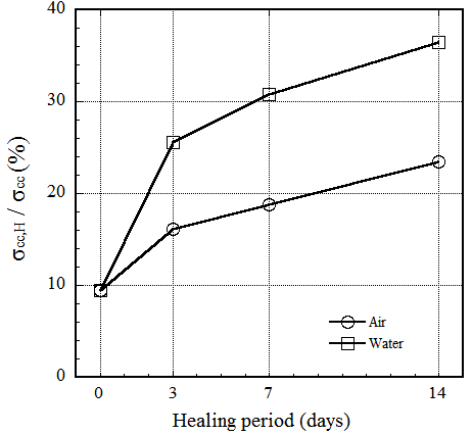
Figure 13. Effect of healing condition on first cracking strength of healed HPFRCCs.